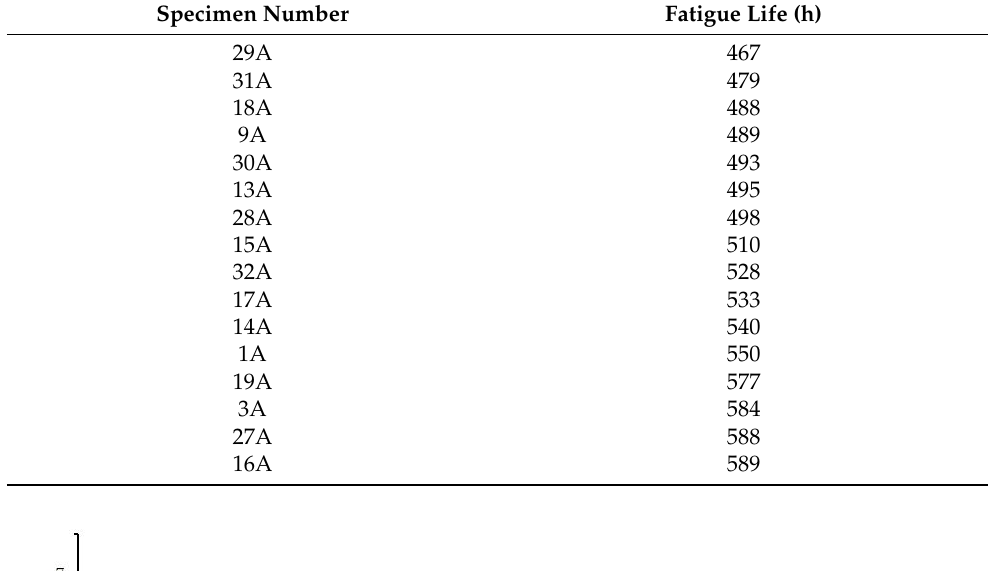
Table 7. Test results for temperature cycling.